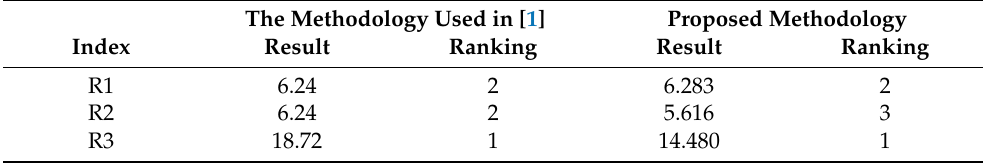
Table 14. Comparison of the impact ranking of the methodology used in [1] and the proposed methodology. The Methodology Used in